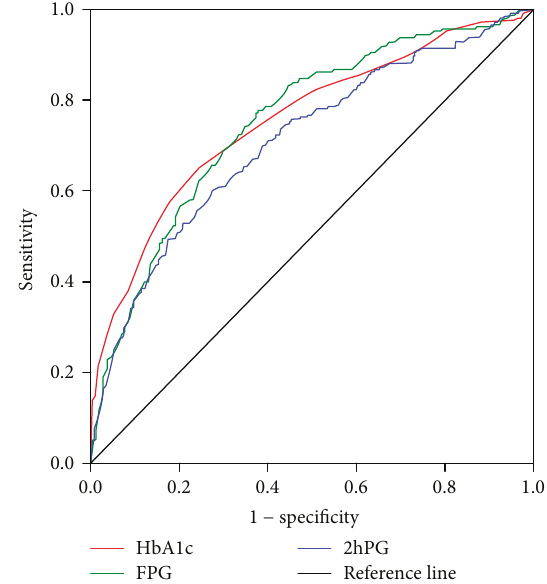
Figure 1: Receiver operating characteristic curve for predicting diabetes after 3 years using baseline blood glucose and HbA1c values. The areas under the ROC curve for FPG, 2hPG, and HbA1c were 0.752 (95% con fi dence interval 0.718 – 0.787), 0.710 (95% con fi dence interval 0.671 – 0.748), and 0.756 (95% con fi dence interval 0.720 – 0.793), 2hPG, and HbA1c were 0.752 (95% con fi dence interval